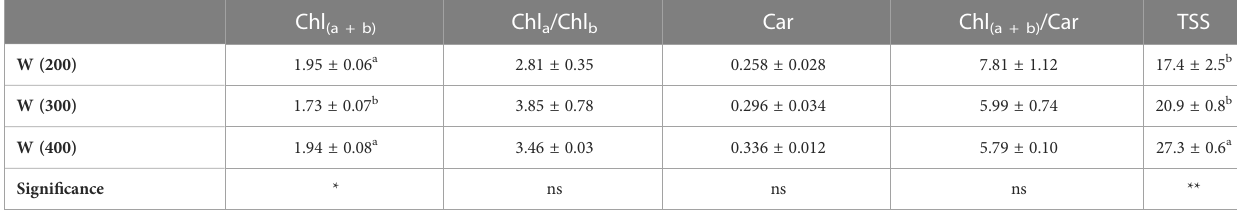
TABLE 3 Foliar photosynthetic pigments concentration (mg mg − 1 FW), total chlorophyll (Chl (a + b) ), chlorophyll a/b ratio (Chl a /Chl b ), total carotenoids (CAR) and Chl (a + b) /Car ratio, and total soluble sugars concentration (TSS, mg g − 1 FW) of perennial ryegrass (cv. Double) under different LED illumination regimes, 100% cool white at 200 [W(200)], 300 [W(300)], and 400 [W(400)] m mol m − 2 s − 1 .